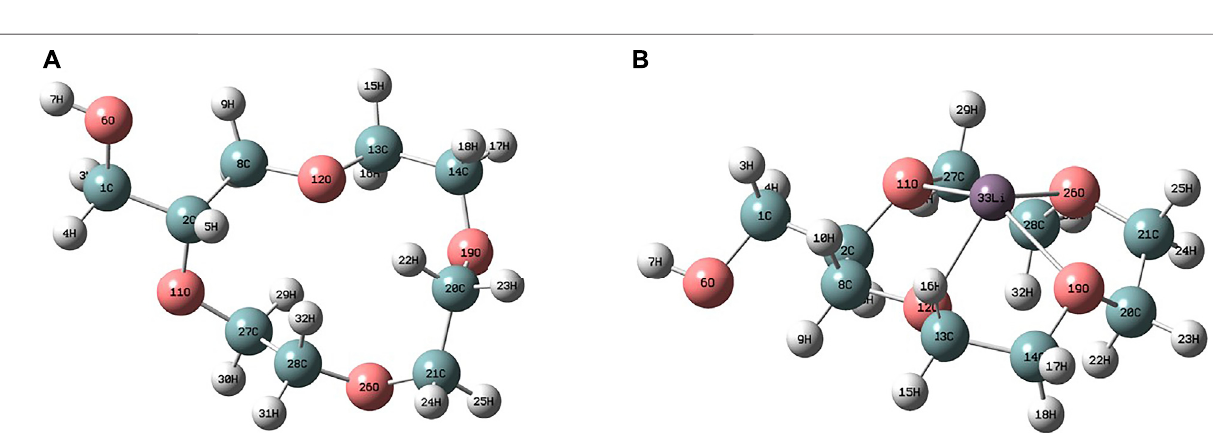
Frontiers in Energy Research |